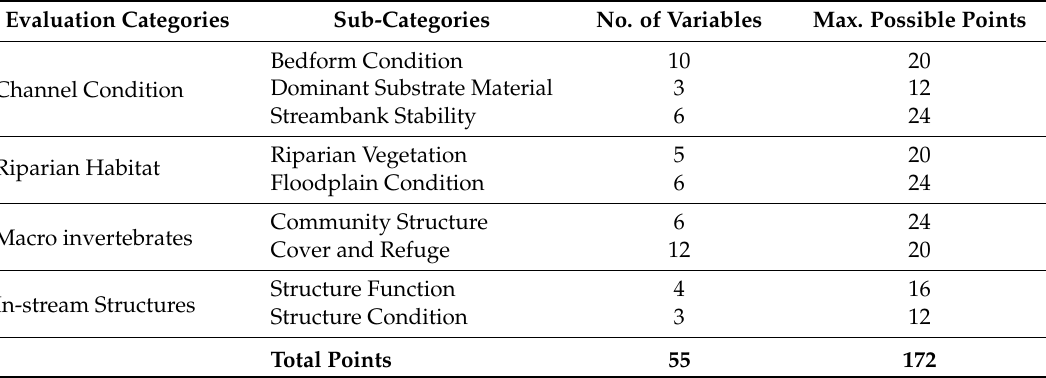
Table 1. EGA stream restoration assessment components.